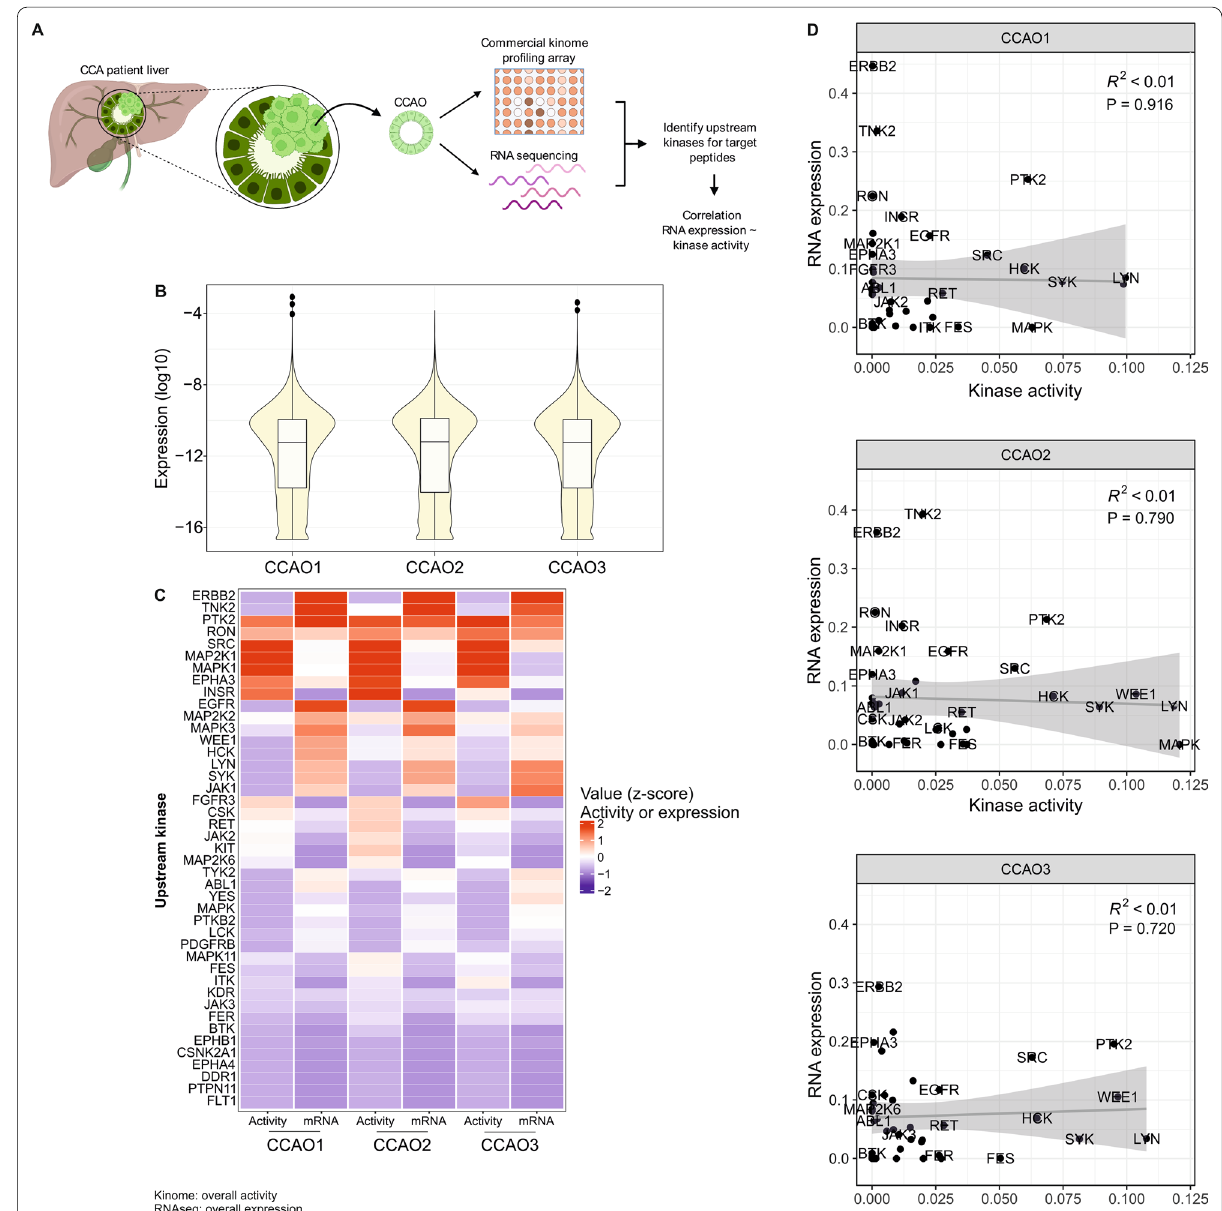
Fig. 1 mRNA expression of kinases does not correlate to kinase activity. A Schematic representation of the workflow. Kinome profiles were established, and RNA sequencing data were acquired for patient-derived CCA organoids (CCAOs). Upstream kinases were identified from the Uniprot and Ensemble databases for the peptides included in the kinome profiling array. Correlation analysis was performed to investigate the relationship between mRNA expression levels and kinase activity. Schematic created with BioRender.com. B Violin plots with box plots of the RNA expression levels show a similar overall distribution of genes in the three CCAO lines. C Heatmap of the activity (AUC of the activity plots) and mRNA expression (normalized counts) of the 37 upstream kinases included in the kinome profiling array in the three CCAO lines. Data is shown by calculated z-score. D Scatter plots demonstrate there is no correlation between the kinase activity and RNA expression level of the upstream kinases in the three